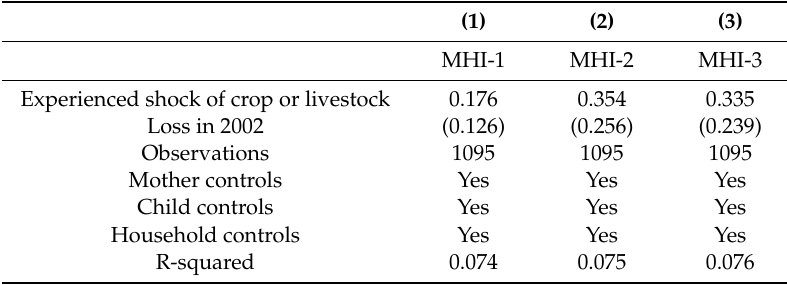
Table A4. Correlations between Shock in 2002 and Maternal Mental Health Index in 2006 /